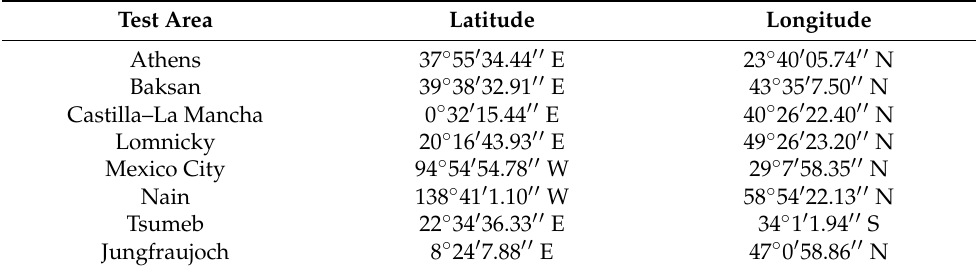
Table 3. The test areas with their